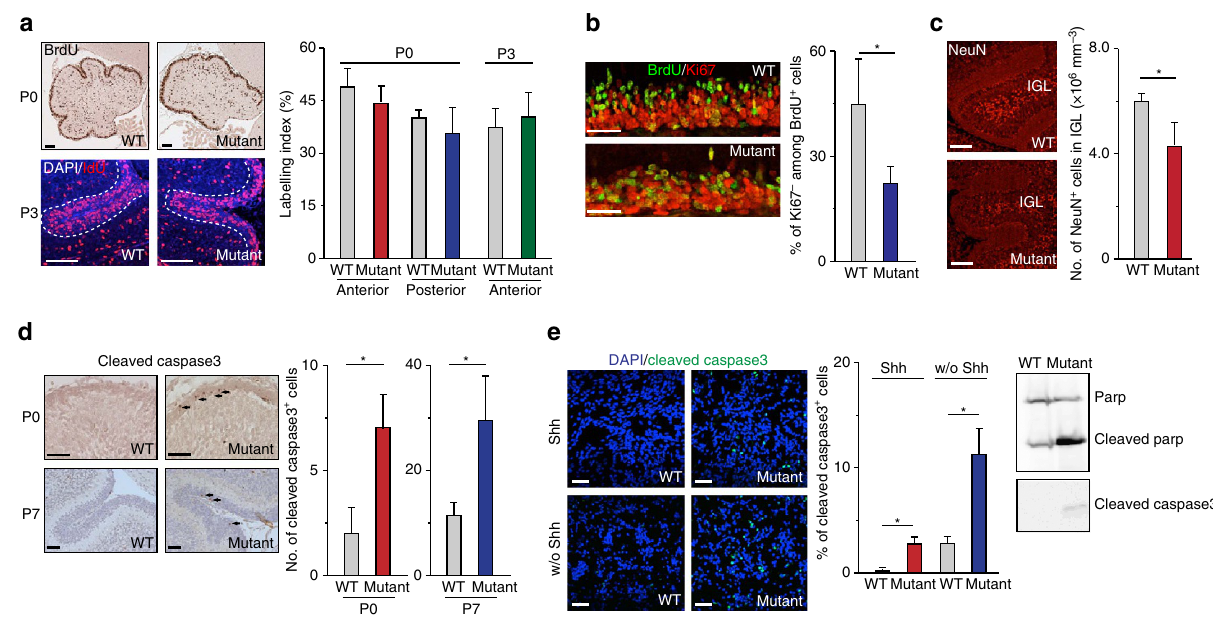
Figure 3 | Mutation of Chd7 in GNPs impairs neuronal differentiation and leads to cell death. ( a ) Immunostaining of BrdU (brown) in P0 and IdU (red) in P3 cerebella from WT [ Chd7 f/f ] and Chd7 mutant [ Atoh1-Cre::Chd7 f/f ] mice pulse-labelled with BrdU or IdU for 2h before the killing. The dashed lines show the inner border of EGL in P3 cerebella. Scale bars, 100 m m. Quantification of the percentage of BrdU- or IdU-positive cells in the EGL within selected areas is shown in the right panel. Bars represent mean value ± s.d. from four mice for each group (for P0) and three mice for each group (for P3). ( b ) Co-immunostaining of BrdU (green) and Ki67 (red) in anterior cerebellar lobules of P7 WT and Chd7 mutant mice subjected to BrdU administration 24h before the killing. Scale bars, 50 m m. The graph represents the percentage of Ki67-negative cells among BrdU-positive cells. Bars represent mean value ± s.d. from three mice for each group. P ¼ 0.047. ( c ) Immunostaining of NeuN in anterior cerebellar lobules of P3 WTand Chd7 mutant mice. Scale bars, 50 m m. Quantification of the number of NeuN þ cells in IGL is shown in the right panel. Bars represent mean value ± s.d. from three mice for each group. P ¼ 0.035. ( d ) IHC of cleaved-caspase3 in P0 and P7 cerebella of WTand Chd7 mutant mice. Scale bars, 50 m m. The number of cleaved caspase3-positive cells (indicated by arrows) in the whole EGL of cerebellar sections was counted (right panels). Bars represent mean value ± s.d. from four mice for each group (for P0, P ¼ 0.0027) and three mice for each group (for P7, P ¼ 0.024). ( e ) Immunostaining of cleaved caspase3 in WT and Chd7 mutant GNPs cultured with or without (w/o) Shh for 48h (left panels). The percentage of cleaved caspase3-positive cells (green) among DAPI-stained cells (blue) was quantified (middle panel). Scale bars, 50 m m. The expression level of Parp, cleaved parp and cleaved caspase3 in WT and Chd7 mutant GNPs cultured without Shh shown by western blots (right panels). Bars represent mean value ± s.d. from five randomly selected areas. P ¼ 2.1E-5 (for Shh); P ¼ 7.7E-5 (for w/o